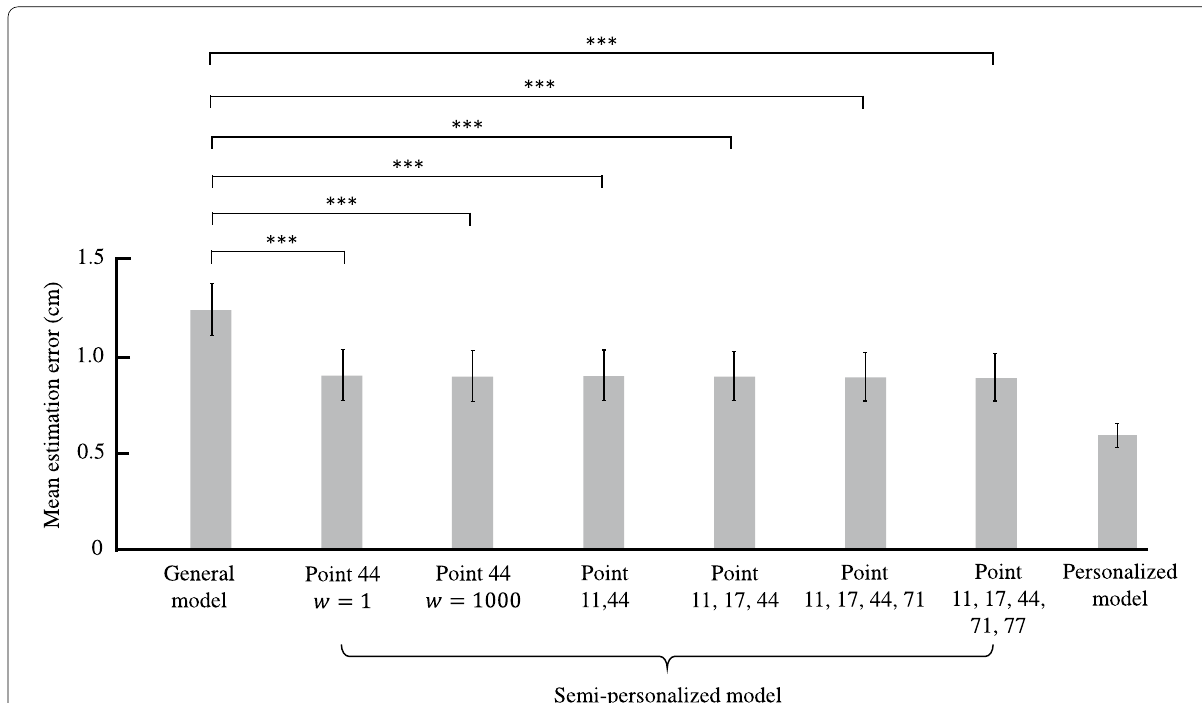
Fig. 7 Comparison of the total mean errors. The general model obviously exhibits greater error than the semipersonalized one. The personalized model with smaller error than those of the general and semipersonalized models is also shown for reference. *** indicates p < 0.001 as per the two‑tailed t ‑test with one sample with no p ‑value adjustment for multiple